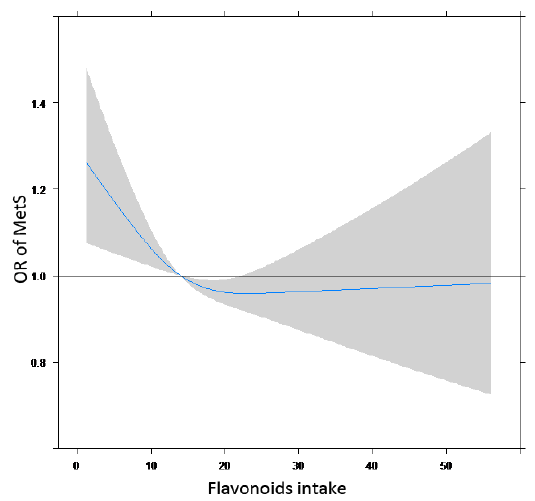
Figure 3. The approximated non-linear trend between the total intake of five flavonoids and the risk of MetS using restricted cubic spline. Data are presented as odds ratios (OR) and 95% confidence intervals of flavonoid intake adjusted for age, body mass index, sex, drinking, smoking, and physical activity.